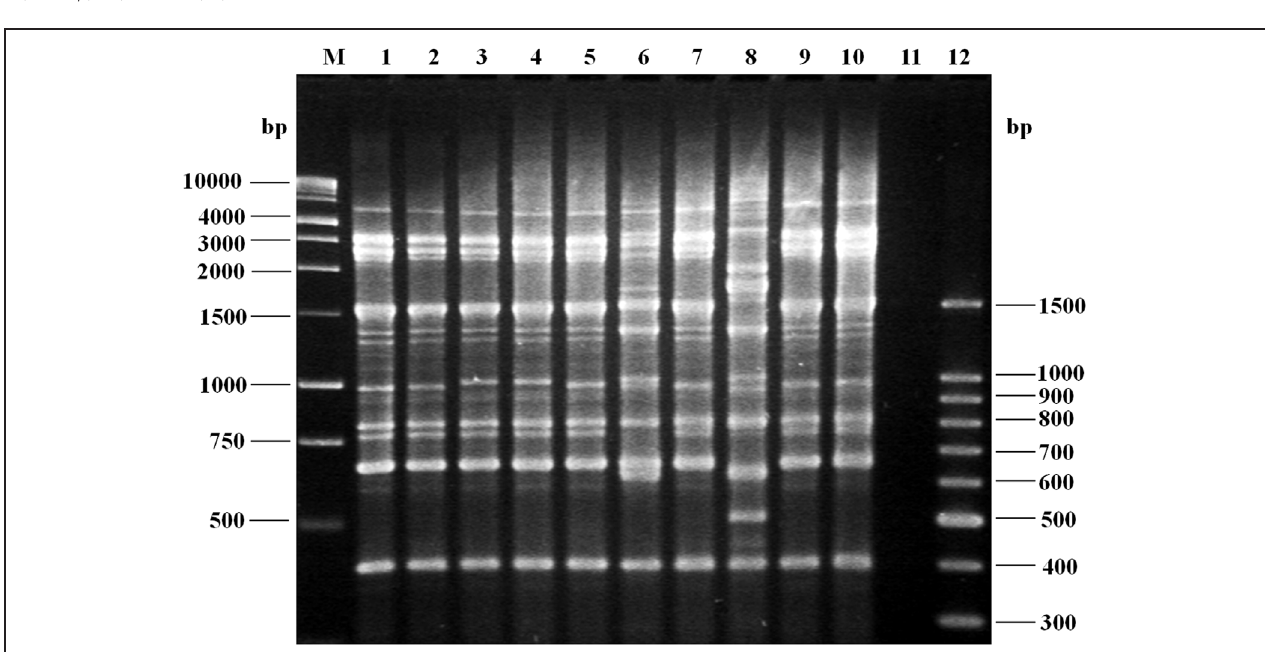
FIGURE 3 | Agarose gel (1.5%) electrophoresis showing the results of polymerase chain reaction (PCR) amplification of representative fingerprint patterns for the REP-PCR of Vibrio parahaemolyticus strains of serotype O3:K6 ( tdh + , toxRS/new + , orf8 + , and trh − ), isolated from 2004 to 2013. Lane M, 1 kb molecular size markers; lane 1, clinical isolate (2004, O3:K6); lane 2, clinical isolate (2006, O3:K6); lane